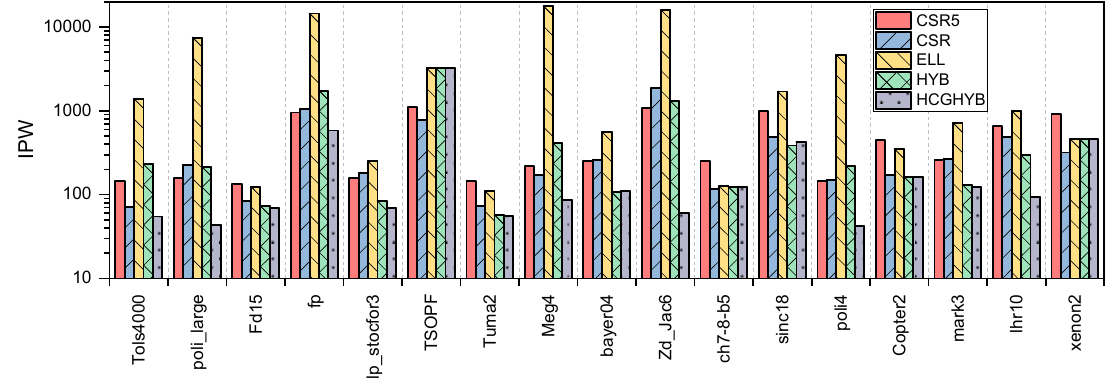
Figure 24. HCGHYB IPW compared to CSR, ELL, HYB, and